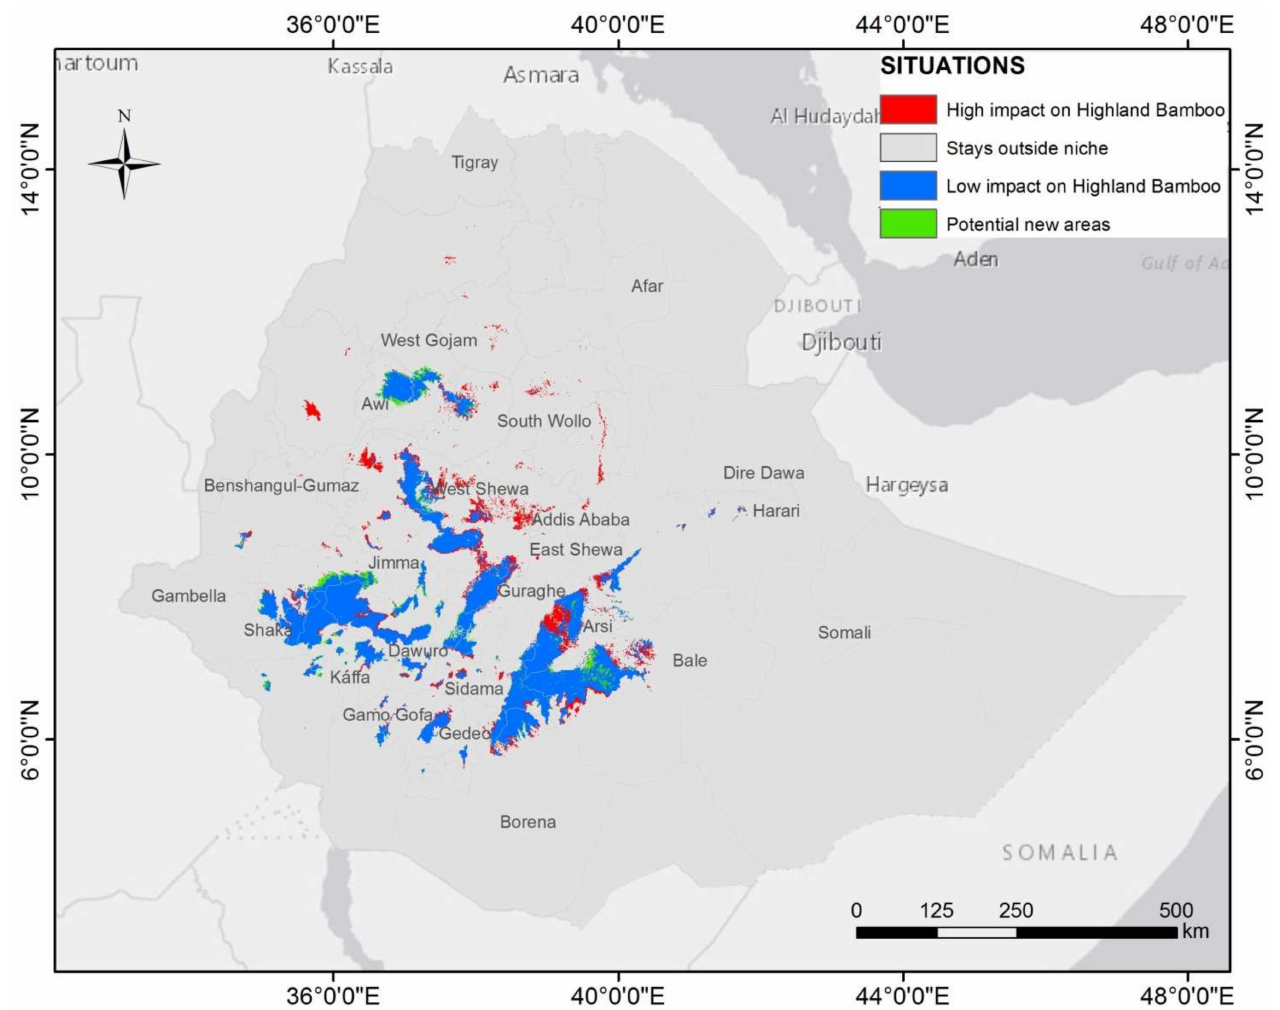
Figure 7. Impact of climate change on habitat niche suitability of highland bamboo under strong forcing scenario